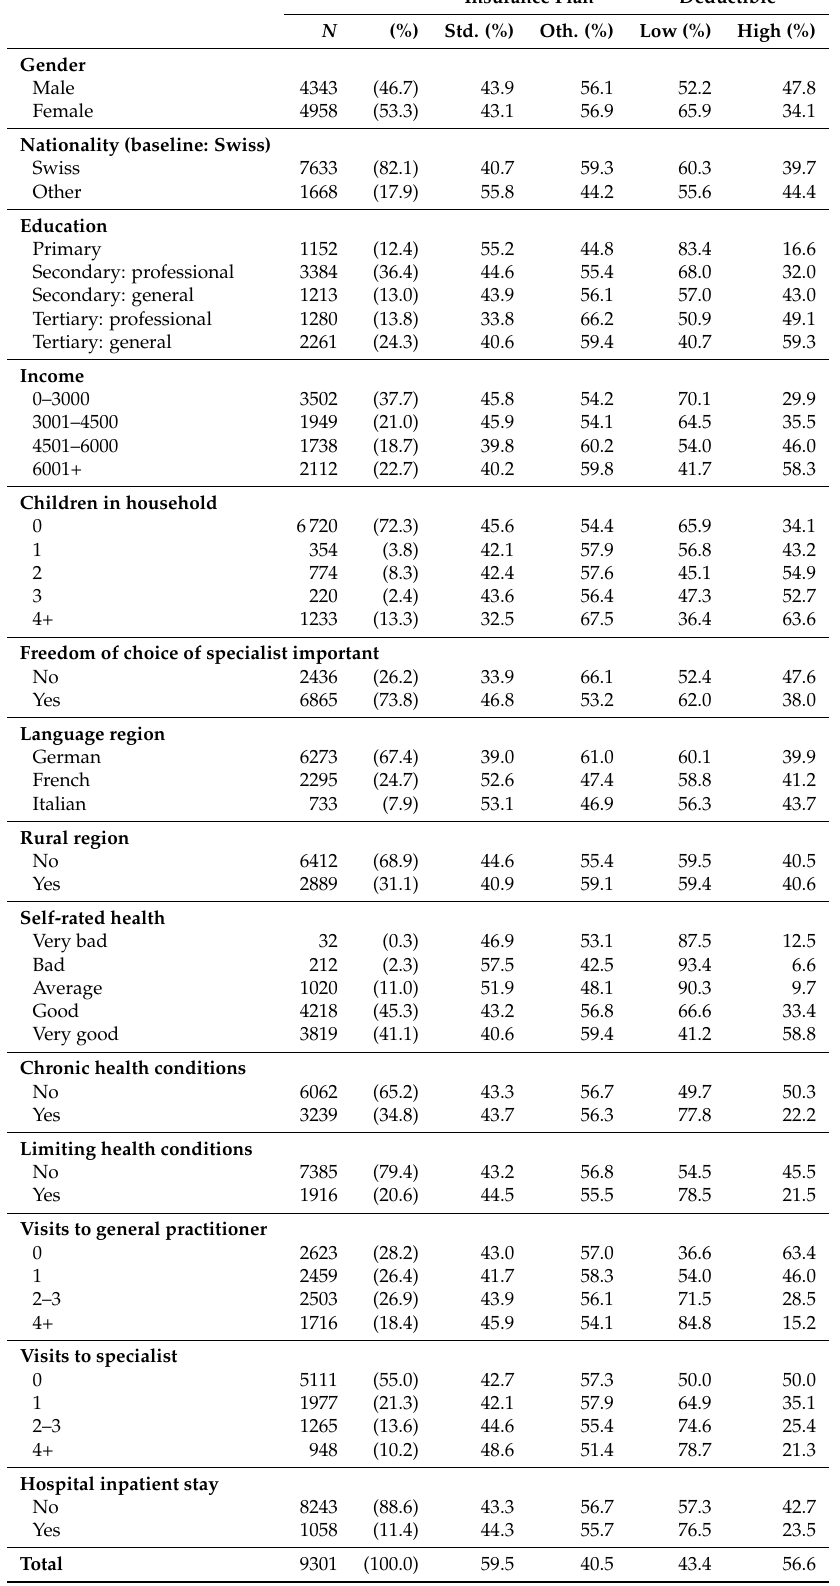
Table 4. Descriptive statistics of the exogenous characteristics affecting insurance